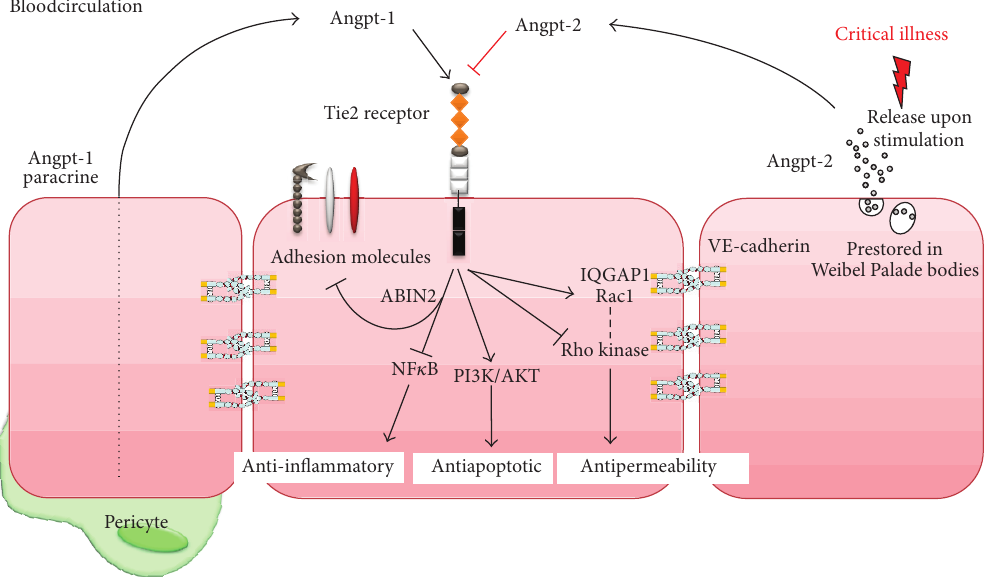
F 1: Scheme of the endothelial angiopoietin (Angpt)/Tie2 system highlighting fundamental signalling pathways. Angpt-1 ligation phosphorylates and thereby activates the Tie2 receptor promoting an anti-in�ammatory signal via inhibition of surface adhesion molecule expression and the transcription factor NB. Moreover, the PI3K/Akt pathway promotes an antiapoptotic, prosurvival signal. e antipermeability effects are induced by maintaining the cytoskeletal architecture in a cortical quiescent formation. On a signalling level this is achieved by simultaneous inhibition of the Rho kinase and activation of the small GTPase Rac1 via IQGAP1 binding. Direct effects on the adherens junction protein VE-cadherin via src have also been reported. Upon stimulation, endothelial cells release prestored Angpt-2 from Weibel Palade bodies into the circulation. Angpt-2 competitively antagonizes positive Angpt-1/Tie2 signalling, thus dramatically activating the endothelial cell and priming it for further in�ammatory